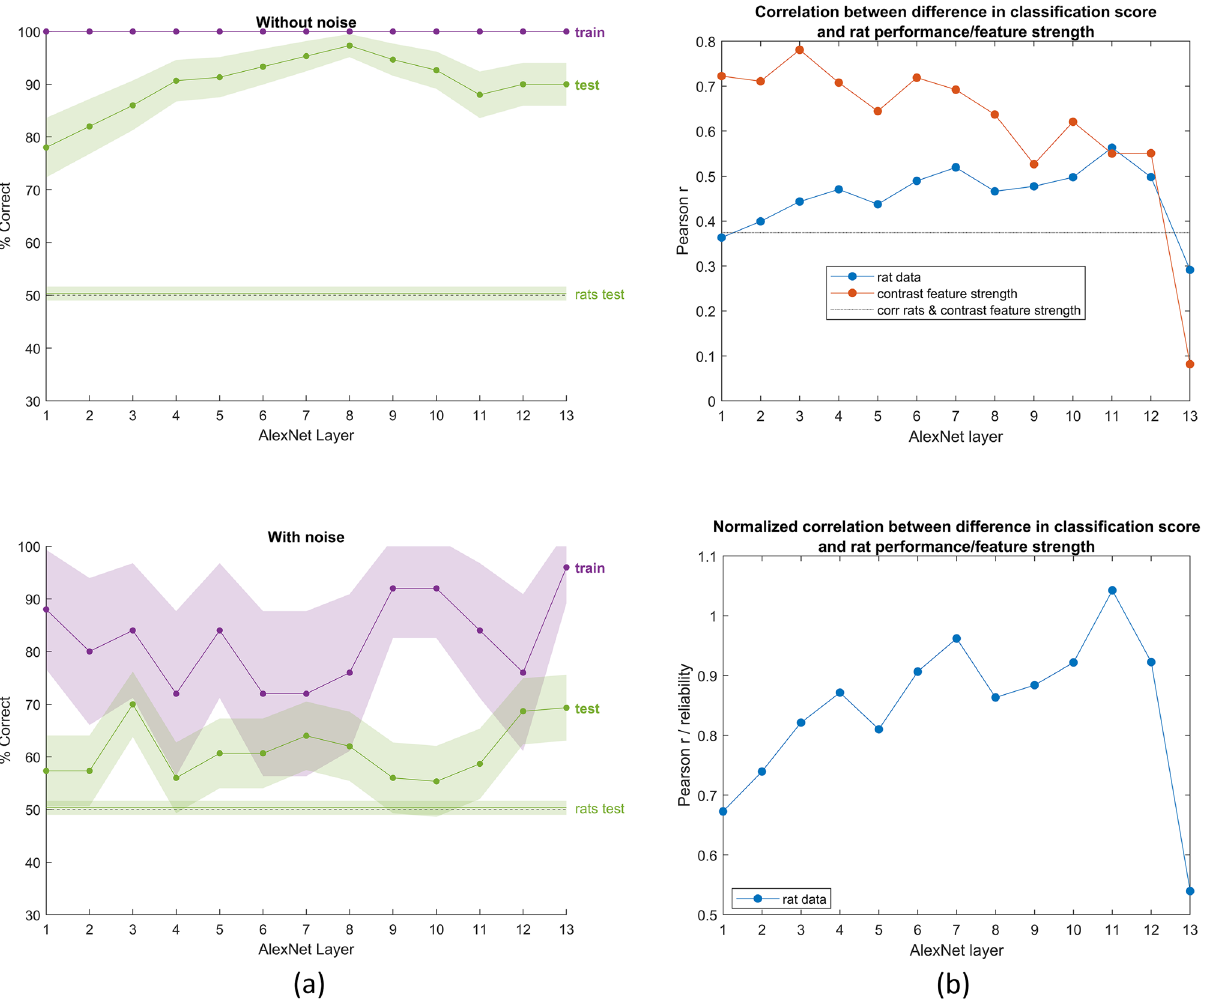
Figure 6. ( a ) The performance of the network after training on our training stimuli, without (top panel) and with noise (bottom panel) added to the data. The purple line indicates the training performance, the green line with dots indicates the test performance of the neural network. The green horizontal line indicates the average generalization performance of the animals, whereas the dashed horizontal black line indicates chance level. The x axis on both graphs indicates the block of layer: layers 1–13 on the x-axis correspond to convolutional layer 1, normalization layer 1, pool layer 1, convolutional layer 2, normalization layer 2, pool layer 2, convolutional layer 3, convolutional layer 4, convolutional layer 5, pool layer 5, fully connected layer 6, fully connected layer 7 and fully connected layer 8, respectively (see our Supplemental Table S1 for an overview of the layer blocks that we use). The shaded error bars correspond to 95% confidence intervals calculated using Jackknife standard error estimates, as done previously in 17 . ( b ) Correlation of the classification score for single target/distractor pairs between single DNN layers and either the rat performance (blue) or the contrast feature strength model (red). The dotted horizontal line indicates the correlation between the rats performance and the contrast feature strength (0.37). The lower panel in ( b ) shows the same data for the correlation with the rat data, but normalized on the reliability of the rat data after the Spearman-Brown correction. The same layer naming convention on the x axis as in ( a ) is